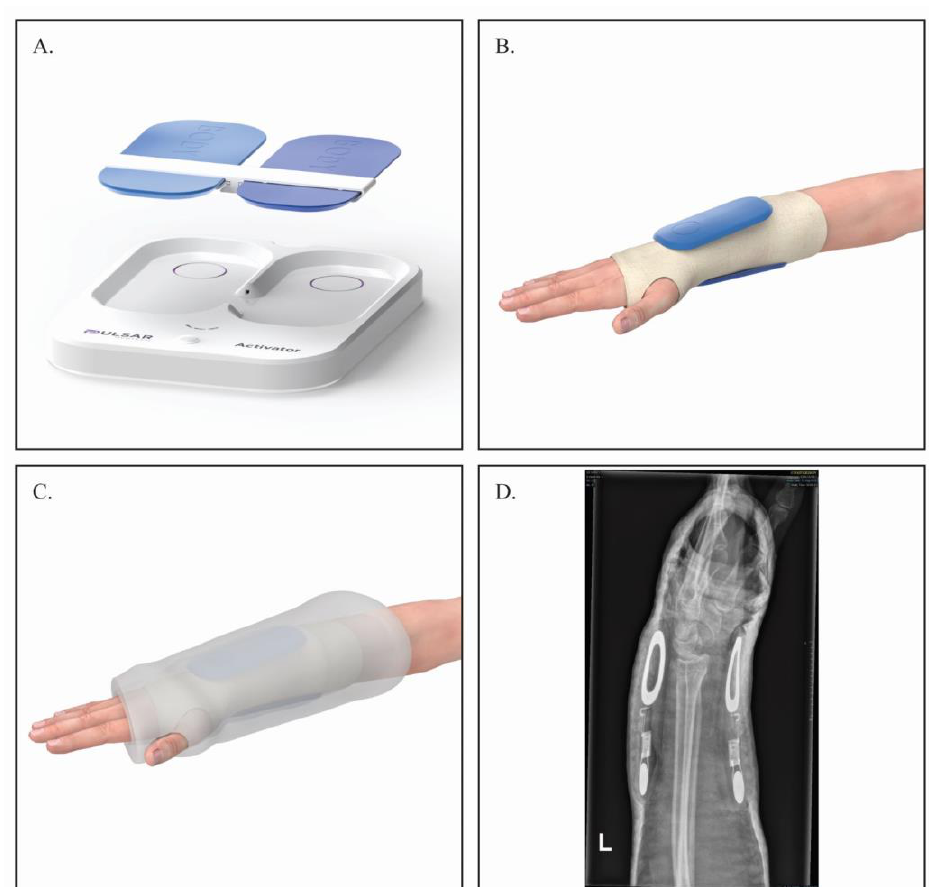
Figure 1. The treatment equipment used in the study. ( A ) A set of Pulsar FHP and activator; ( B ) activated or sham FHP placed on the patient’s hand over the Velband dressing; ( C ) schematic presentation of the FHP under the cast; ( D ) representative X-ray, of the FHP placed under the cast (lateral view).